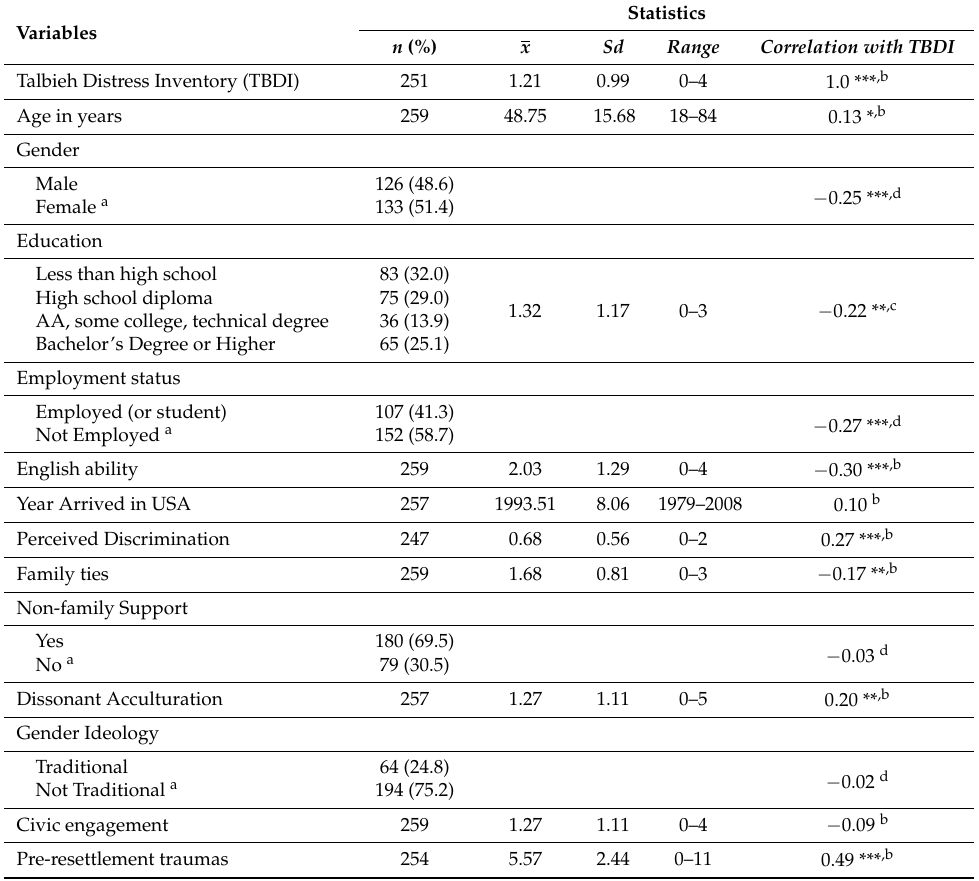
Table 1. Descriptive statistics: dependent, control, independent variables, and bivariate relationships with dependent variable ( n =